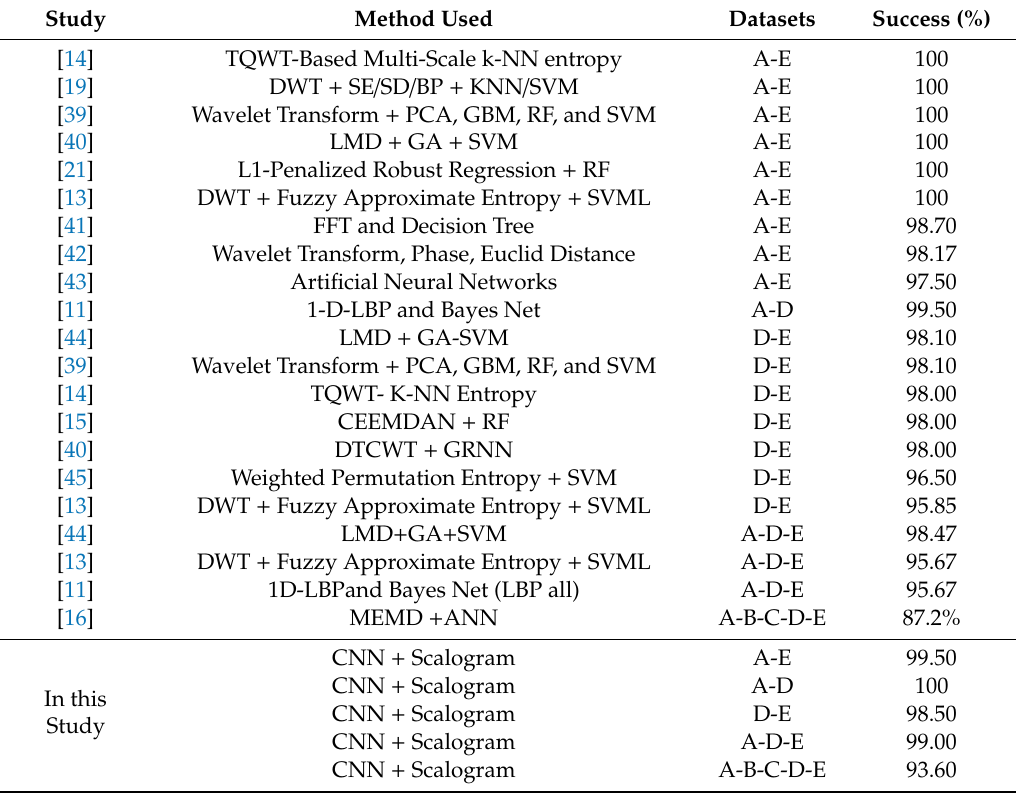
Table 9. The Reported Works on the Classification of Bonn EEG